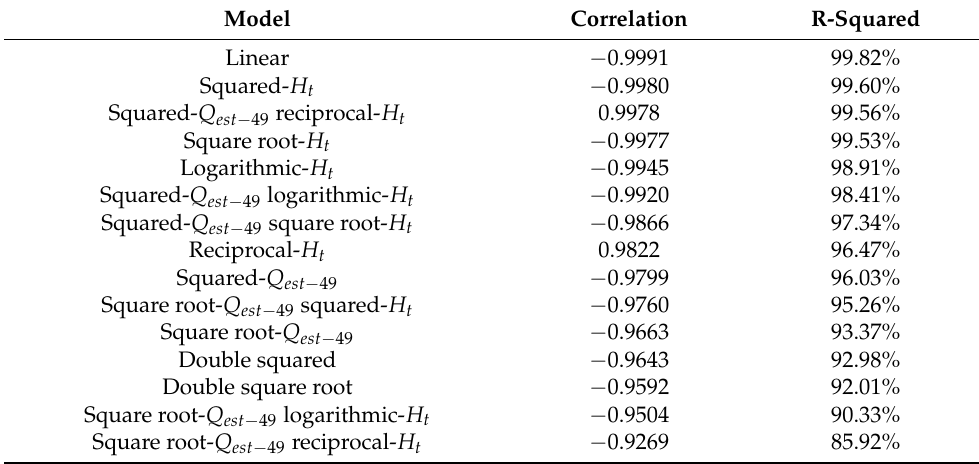
Table 2. Comparison of alternative models obtained by the Statgraphics Centurion software using Pearson correlation and R-Squared value coefficient of